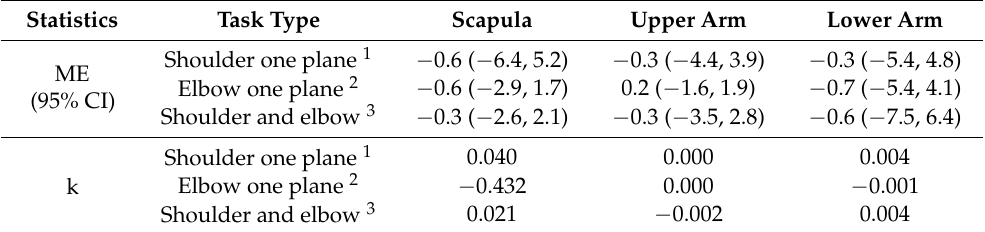
Figure 3. Bland–Altmann plots illustrate system agreements of the IMU system with the reference system. The helical angle was calculated for each segment, scapula ( A ), upper arm ( B ) and forearm ( C ). Angular errors were calculated for tasks involving large shoulder movements in one plane (upper row, shoulder flexion − extension, MMS1 global abduction and MMS2 global external rotation), for elbow mobility tasks (middle row, elbow flexion − extension and forearm pronation–supination); tasks involving movement in both elbow and shoulder (bottom row, MMS3 hand to neck, Mallet MMS4 hand to spine, MMS5 hand to mouth and MMS6 internal rotation). The mean error is illustrated with a blue line, and the error 95% confidence intervals are marked with red lines. Table 2. Comparison between a reference system and the IMU system. The mean error (MR), the error confidence interval (95% CI), and error slope (k) from linear regression are presented for different types of movements. The error is based on the segment helical angle.